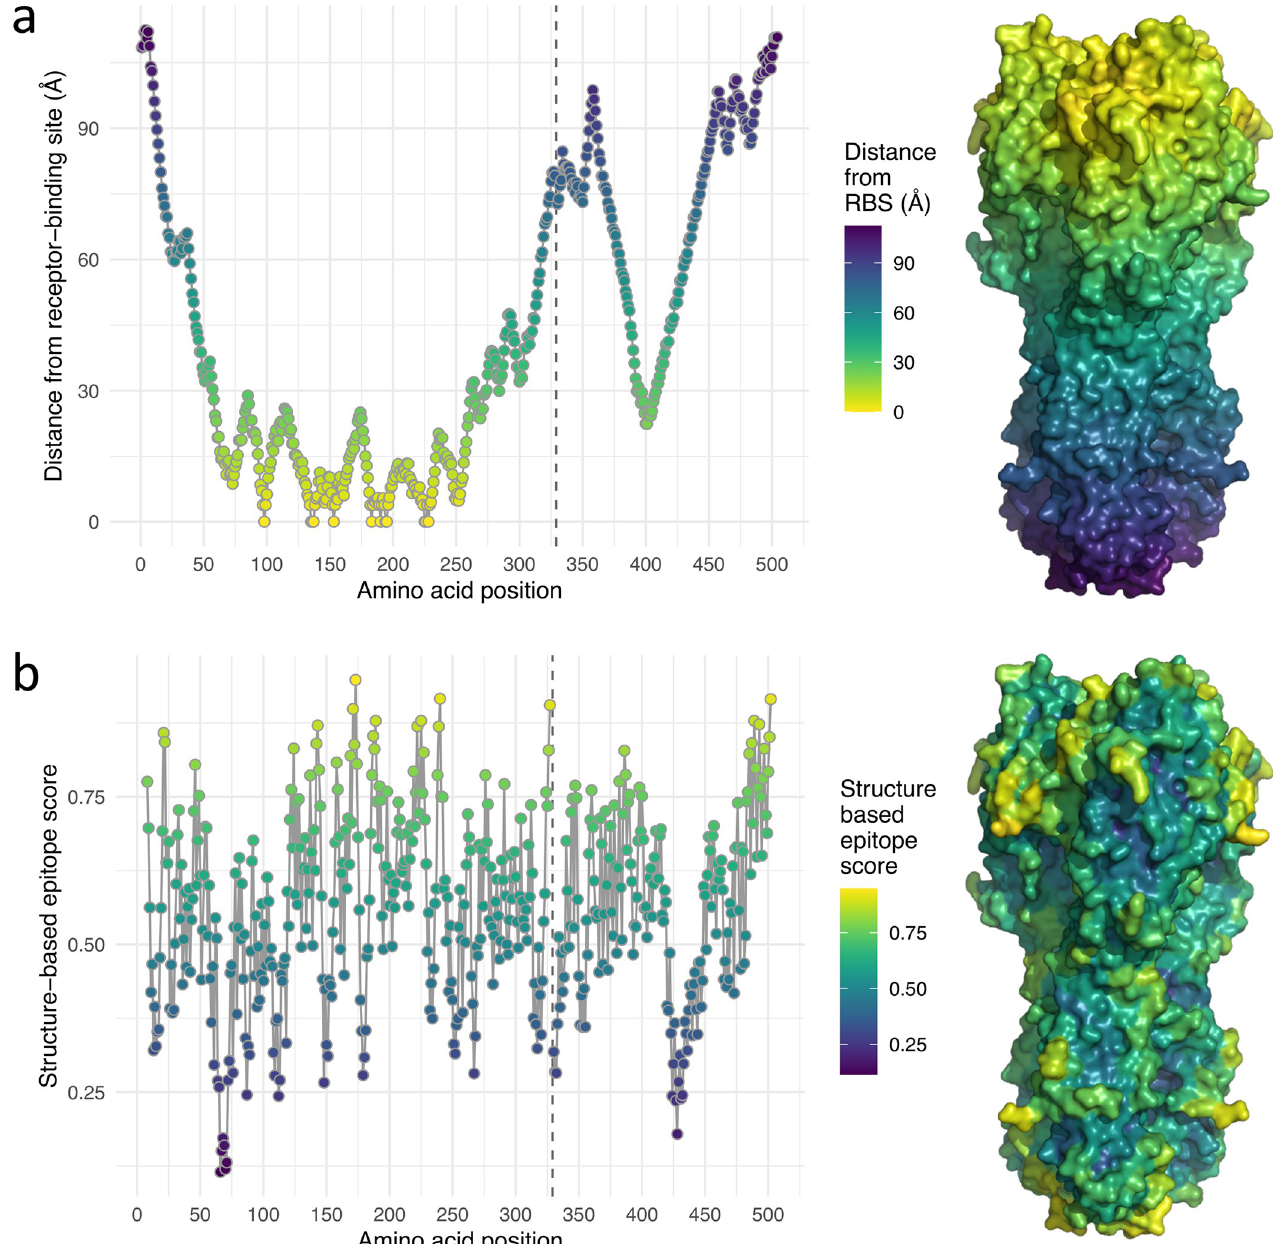
Fig 3. Structural features of the influenza A(H3N2) HA. ( a ) The distance of each HA residue to the closest of the residues comprising the RBS. To the right, a surface representation of the HA structure is shown coloured according to the distance key. ( b ) The structure-based epitope score for each HA residue was calculated using BEpro [23]. To the right, a surface representation of the HA structure is shown coloured according to the epitope score key. In each plot, a vertical dashed line at position 329 indicates the boundary between HA1 and